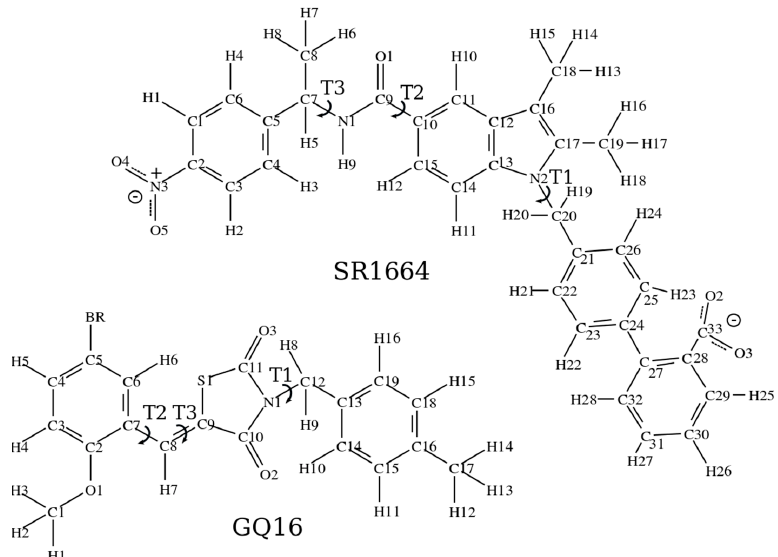
Figure 1. Chemical structures of the PPAR γ ligands SR1664 and GQ16, indicating atom numbering and the parameterized torsions. The arc-shaped arrows indicate the torsion (T) bonds for which full revolution is possible.